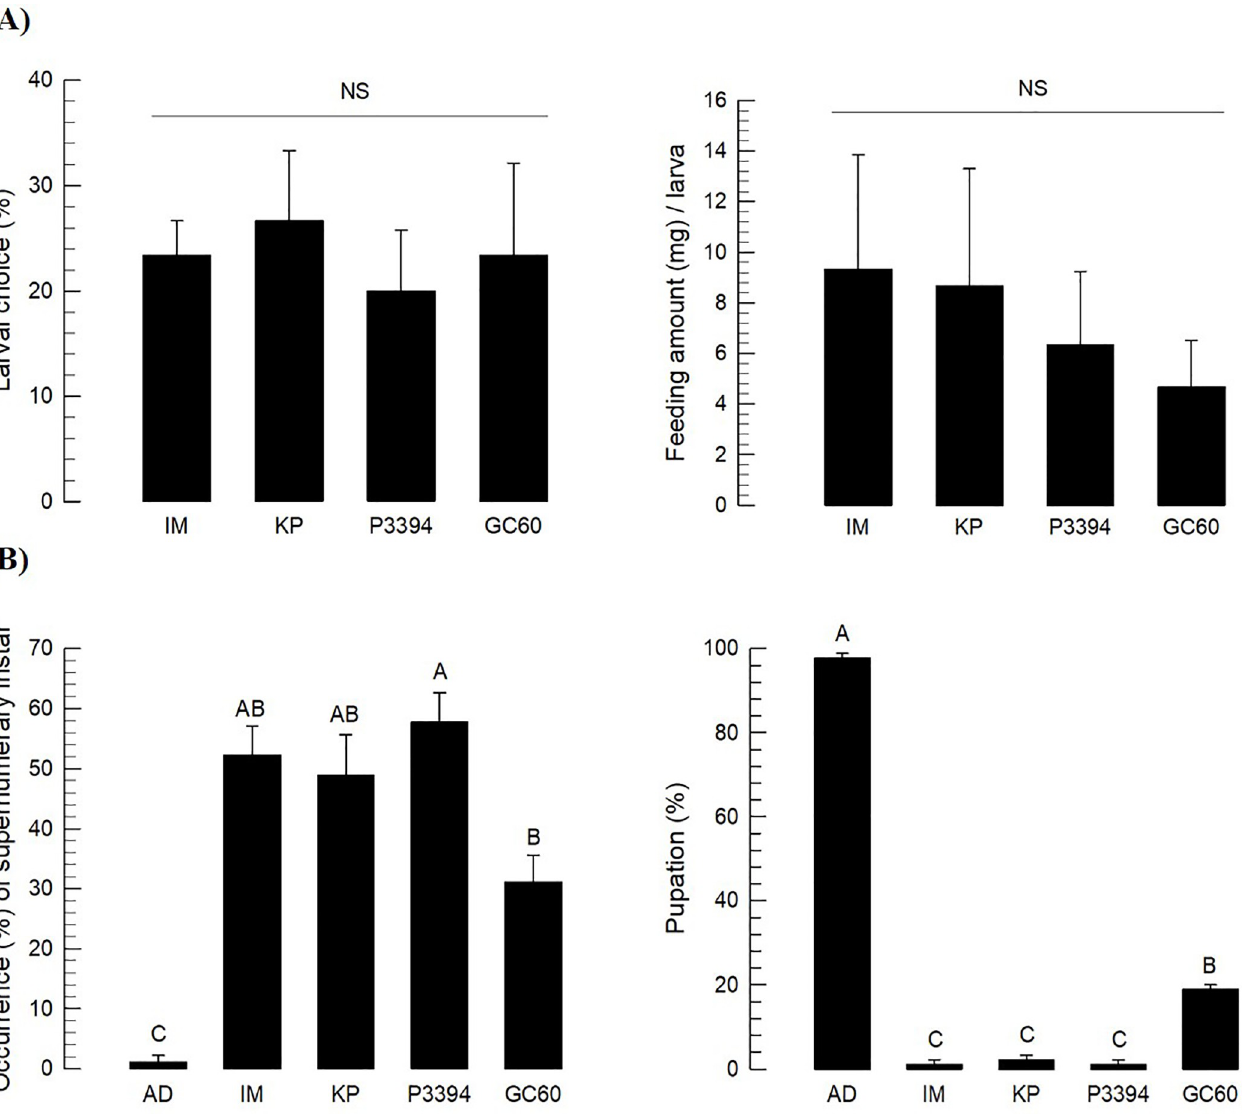
Fig 1. Insect resistance assays of three resistant corn varieties (Ilmichal (‘IM’), Kwangpyeongok (‘KP’) and P3394) and one susceptible (Gwangwonchal 60 (‘GC60’)) against O . furnacalis . (A) Antixenosis assessment. L3 larvae were used in choice test. Each test was replicated three times. For each replication, 10 larvae were used. Left panel: Choice test of O . furnacalis among three corn varieties in Petri dish assay. Right panel: Variation in their feeding amount for 48 h. (B) Antibiosis assessment. ‘AD’ stands for artificial diet as a reference. Newly hatched larvae were reared with different diets until emergence. Each treatment was replicated three times. For each replication, 30 larvae were used. Different letters above standard error bars indicate significant difference among means at Type I error = 0.05 (Tukey test). ‘NS’ stands for no significant difference.